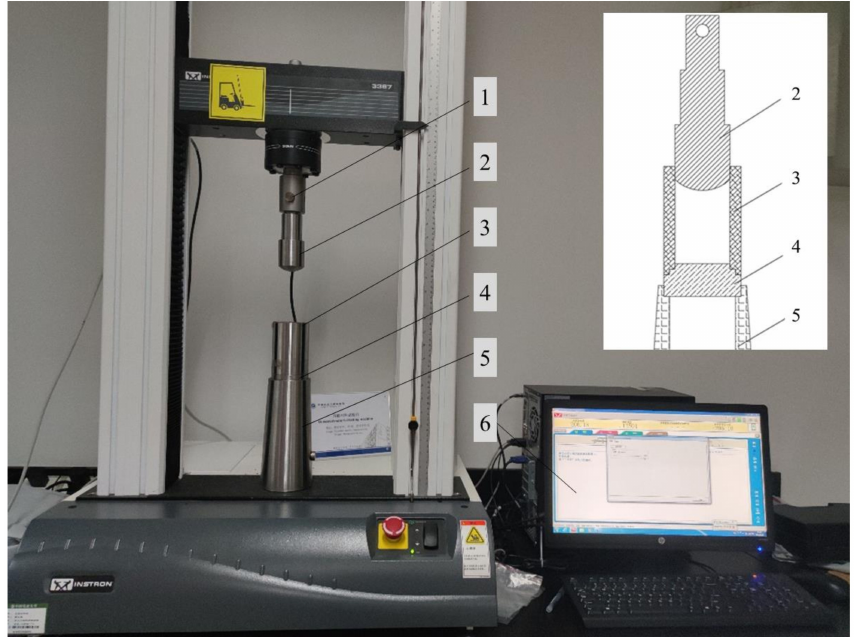
Figure 1. Test system for cold compression molding. 1. Positioning screws; 2. Punch-pin; 3. Cavity mold; 4. Die cushion; 5. Stripper; 6. Control and display